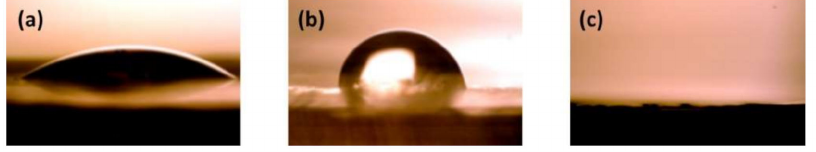
Figure 3. Sessile-drop measurements: pictures of droplets of ( a ) deionized water, ( b ) 0.6 M aqueous solution of K 2 SO 4 , and ( c ) n -decane on the surface of porous silicon membrane (5.0 ×